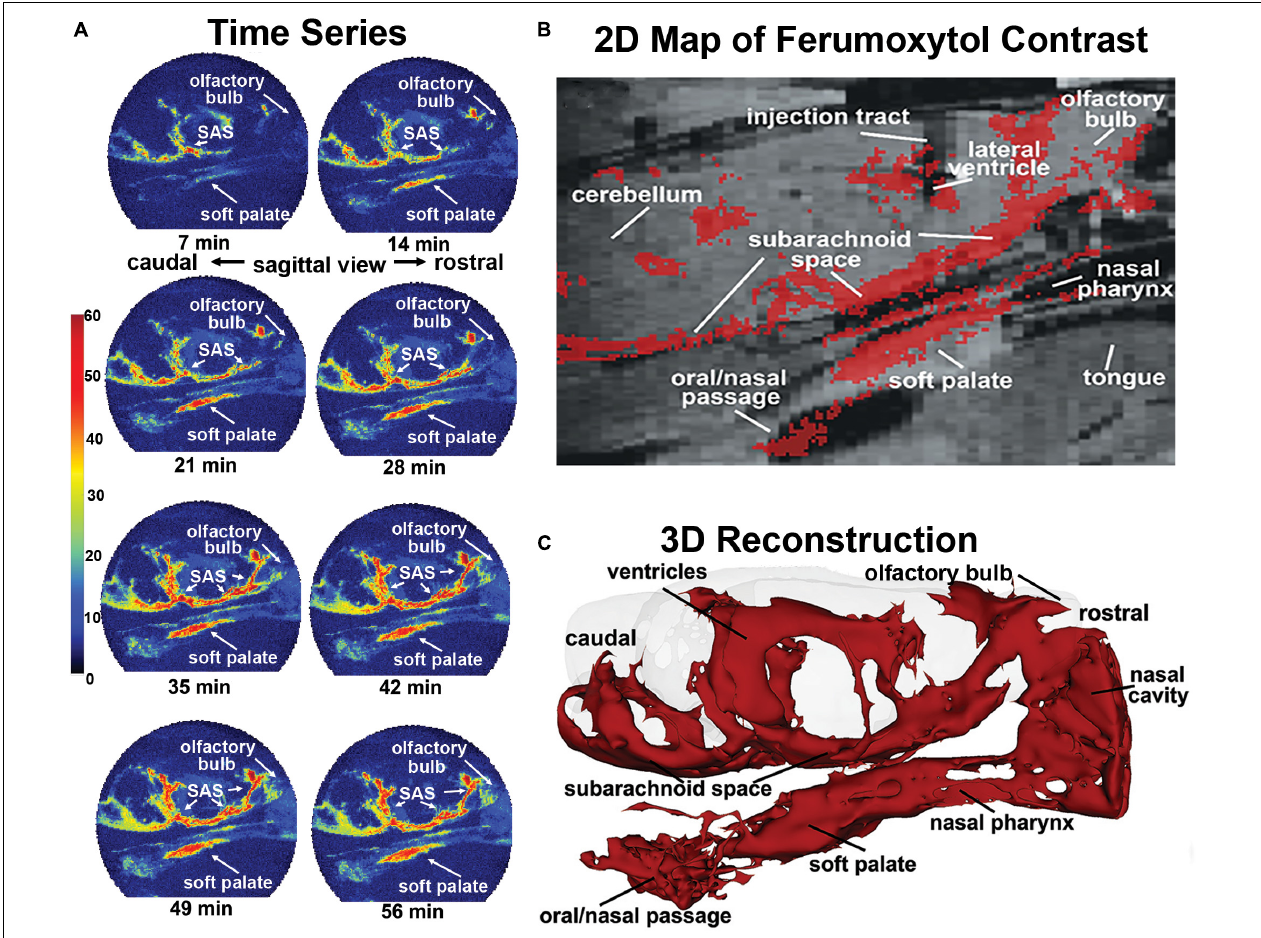
FIGURE 5 | Mapping clearance from brain to soft palate. Shown is the movement and accumulation of ferumoxytol. The time series (A) are from a single subject, collected at 7-min intervals over 70 min long scanning session. A summary image (B) of the average CA signal from six rats is mapped onto the T2 weighted anatomy image of the brain. (C) The 3D reconstruction of CA within and outside the brain from a single subject at the end of the imaging study. (Adapted with permission from Leaston et al.,